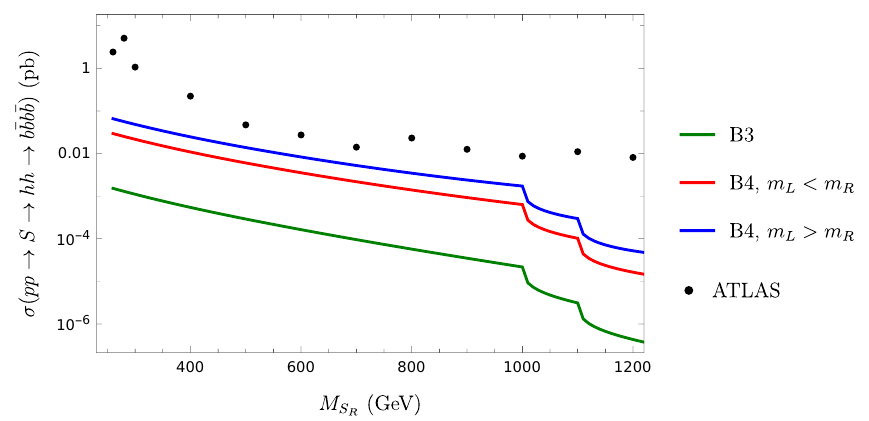
Figure 13 . Resonant Higgs pair production and decay to bottom pairs in benchmarks B3 and B4 (shown with both stop mass orderings). Black points represent the ATLAS observed exclusion bound from [45].